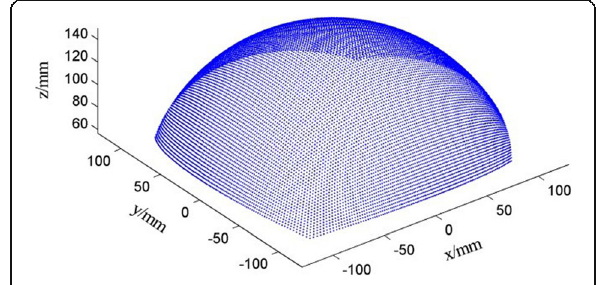
Fig. 3 Working space of the developed haptic device